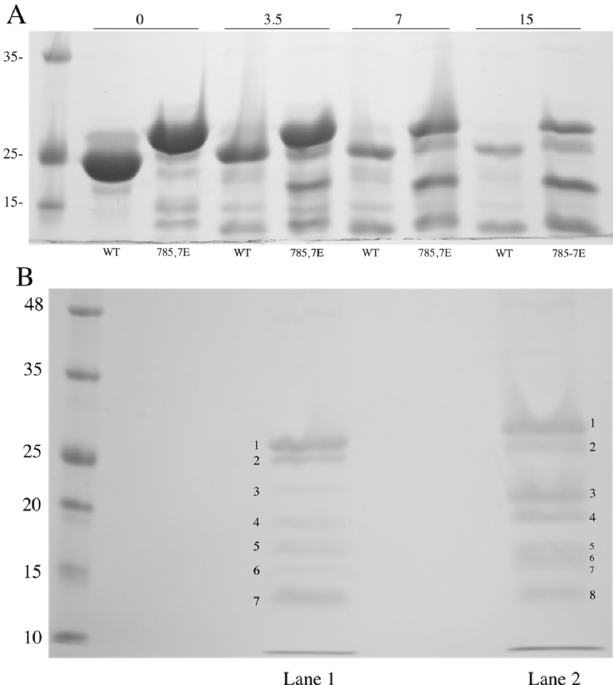
Figure 4. Differential mobility and trypsin sensitivity of wild-type (WT) and mutant NHE1 proteins. ( A ) His-182 NHE1 protein and His-182 with the 785E, 787E mutations were purified as described in Section 4 and treated with increasing amounts of trypsin (3.5, 7, and 15 ng) for 30 ◦ C × 5 min. Reactions were terminated with SDS-PAGE sample buffer and run on 12% PAGE. ( B ) Tryptic digest of 35 µ g of wild-type (Lane 1) or phosphomimetic (Lane 2) His-182 protein with 10 ng trypsin for 10 min (30 ◦ C). Fragments excised for mass spectrometry are